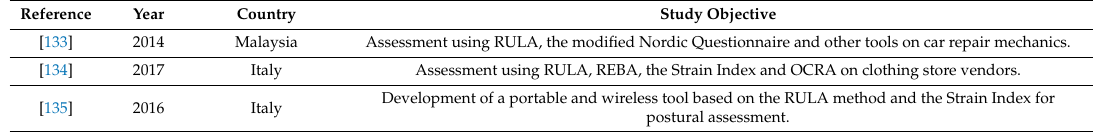
Table 8. Wholesale and retail trade; repair of motor vehicles and